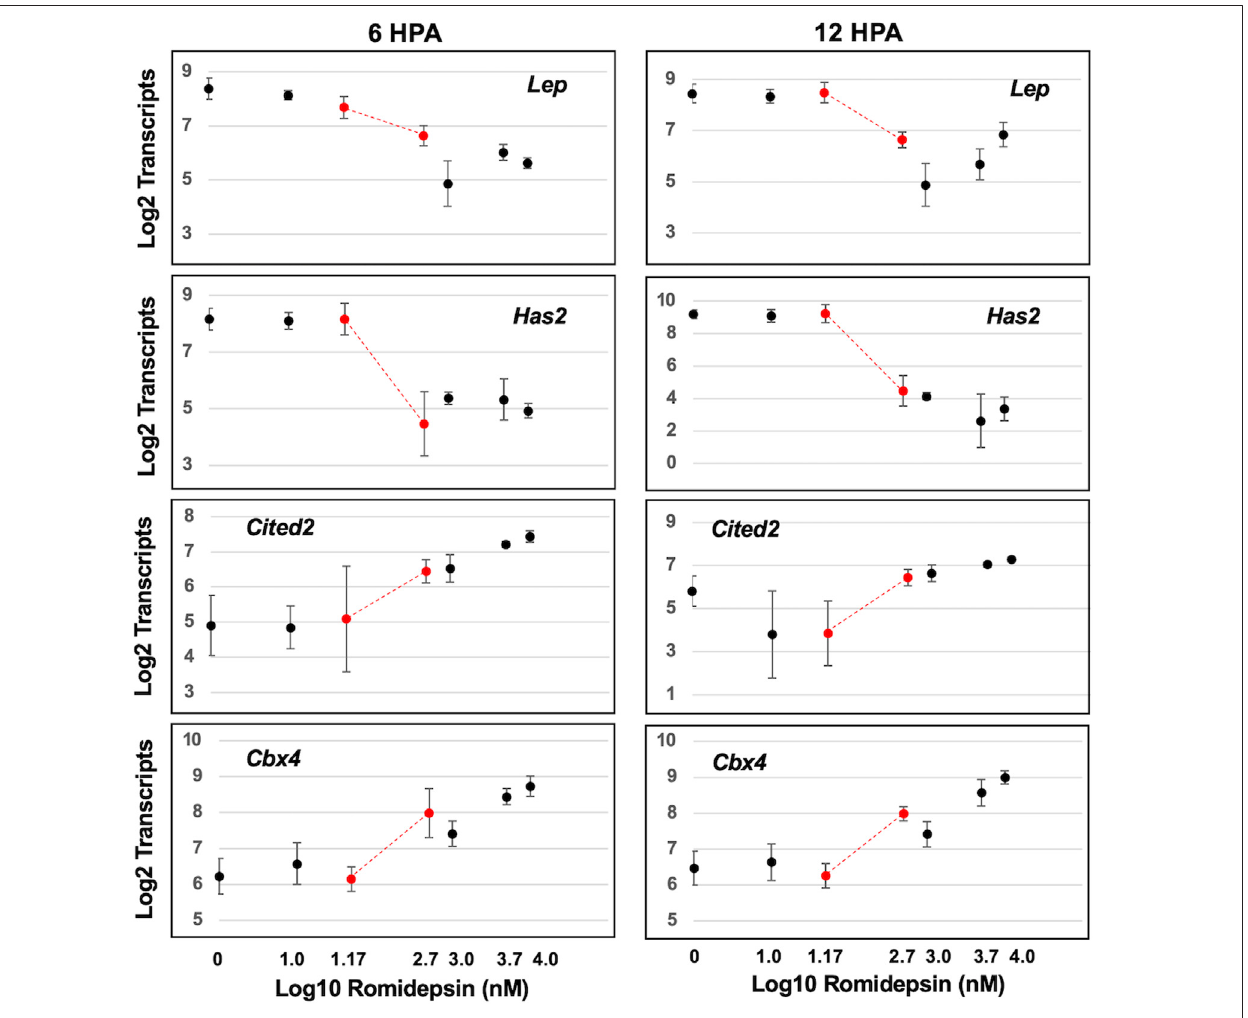
FIGURE2| Concentrationdependenteffectofromidepsinontranscription.Examplesoffourgenesthatwereclassi fi edasexhibitingsigmoidaltranscriptresponse curves. Has2 and Lep transcripts decreased within increasing romidepsin concentration. Cited2 and Cbx4 transcripts increased with increasing romidepsin concentration. The red dots correspond to romidepsin concentrations that were associated with regenerative (0.05 μ M) and non-regenerative outcomes (0.5 μ M).